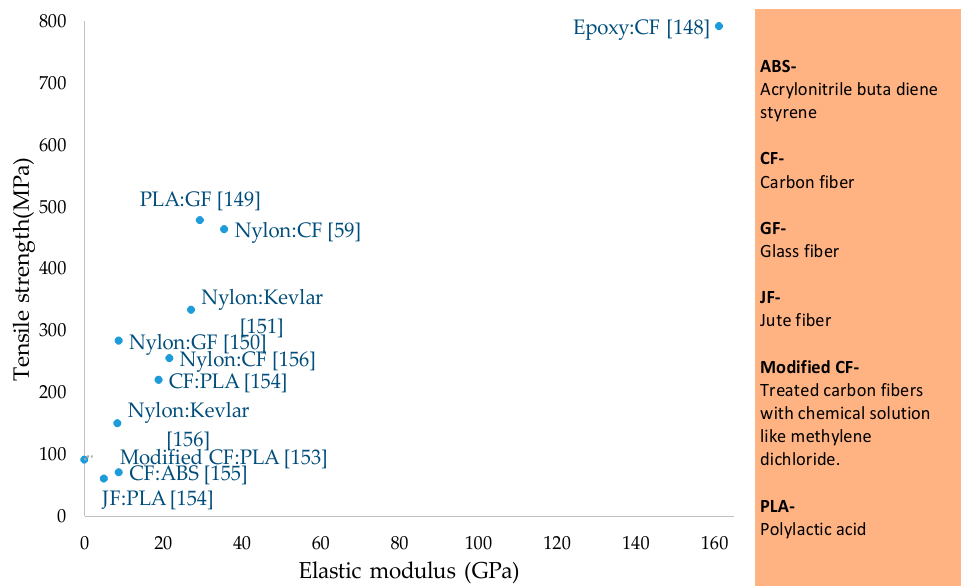
Figure 9. Tensile strength and elastic modulus of continuous fiber reinforced materials.